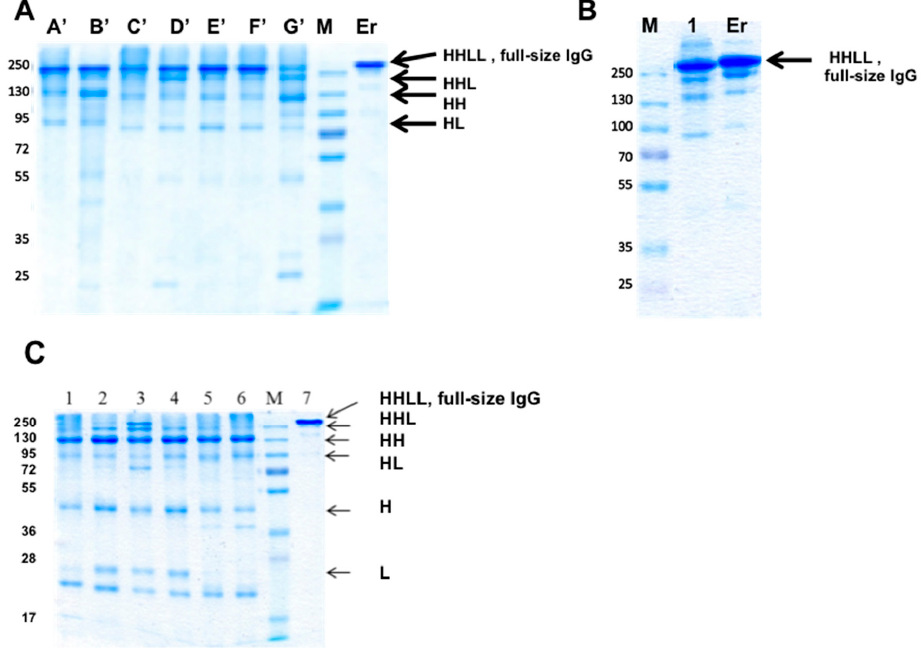
Figure 8. Evaluation of bsAb assembly by SDS/PAGE. ( A ) The purified “disulfide-stabilized IgGs” engineered at the CH1-CL interface; molecules engineered on the T427 Fab arm (Kappa light chain): A-G represent the seven bsAb mutants as listed in Table 1. (A’) Heavy chain T427 F174C, C222A; Light chain T427 S162C, C214 Δ ; (B’) Heavy chain T427 F174C, C222A; Light chain T427 T164C, C214 Δ ; (C’) Heavy chain T427 L124C, C222A; Light chain T427 F118C, C214 Δ ; (D’) Heavy chain T427 F122C, C222A; Light chain T427 S121C, C214 Δ ; (E’) Heavy chain T427 F122C, C222A; Light chain T427 E123C, C214 Δ ; (F’) Heavy chain T427 F122C, C222A; Light chain T427 Q124C, C214 Δ ; (G’) Heavy chain T427 S130C, C222A; Light chain T427 F118C, C214 Δ ; (M) protein size marker (MW in kDa); ( B ) A bsAb engineered on the anti SA Fab arm (Lambda light chain): 1 α SA IgG carrying mutations Heavy chain Q175C, C222A and Light chain E160C, C214A. Er-Erbitux ® shown as a reference to full-size IgG. The arrows indicate the different chains composition in the sample, where L = Light chain and H = Heavy chain; ( C ) Analysis of the “illegitimate pairing” family. All mutants consist of Heavy chain T427 WT + a mutant of Light chain as follows: C214 Δ + 1) F118C (light chain of mutant C from Table 1); (2) S121C (light chain of mutant D from Table 1); (3) E123C (light chain of mutant E from Table 1); (4) Q124C (light chain of mutant F from Table 1); (5) S162C (light chain of mutant A from Table 1); (6) T164C (light chain of mutant B from Table 1); (7) Erbitux ® (used as a full-size IgG protein marker). The arrows mark the different chains composition in the samples, where L = Light chain and H = Heavy chain. The purified antibodies were separated on a 10% SDS-PAGE under non-reducing conditions and visualized using GelCode Blue™ staining.